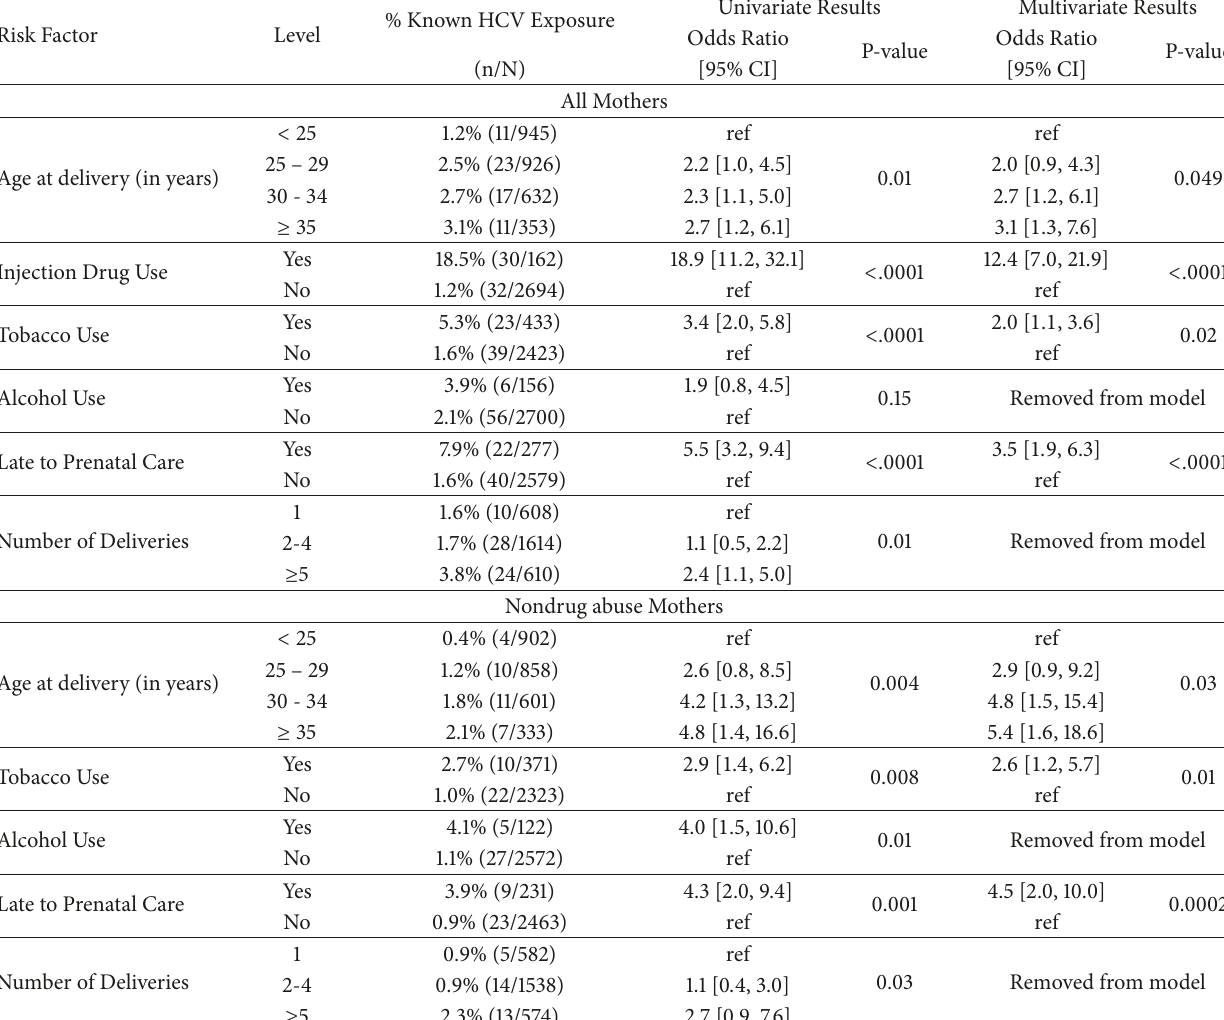
Table 1: Raw and adjusted odds ratios for documented exposure to hepatitis C among women who delivered infants,